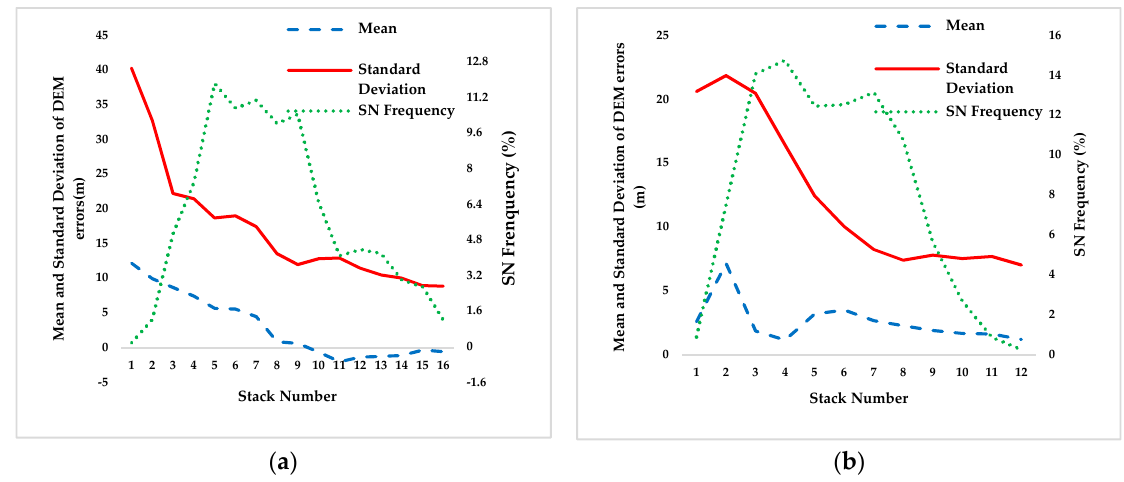
Figure 6. Mean and standard deviation of the DEM errors versus stack number (SN) for ( a ) ASTER GDEM and ( b ) AW3D30. The frequency of SN values is also shown as a separate curve.